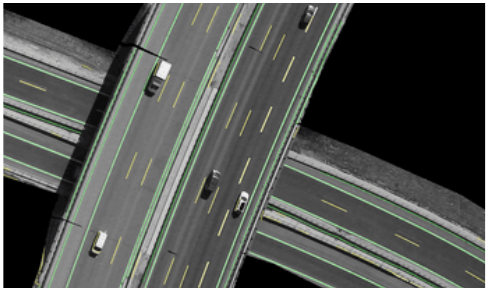
Figure 3. The extracted continuous lane-lines are marked in green and the dashed in yellow. Both cases are reconstructed into 3D with the same framework; different colors here are only for illustration.